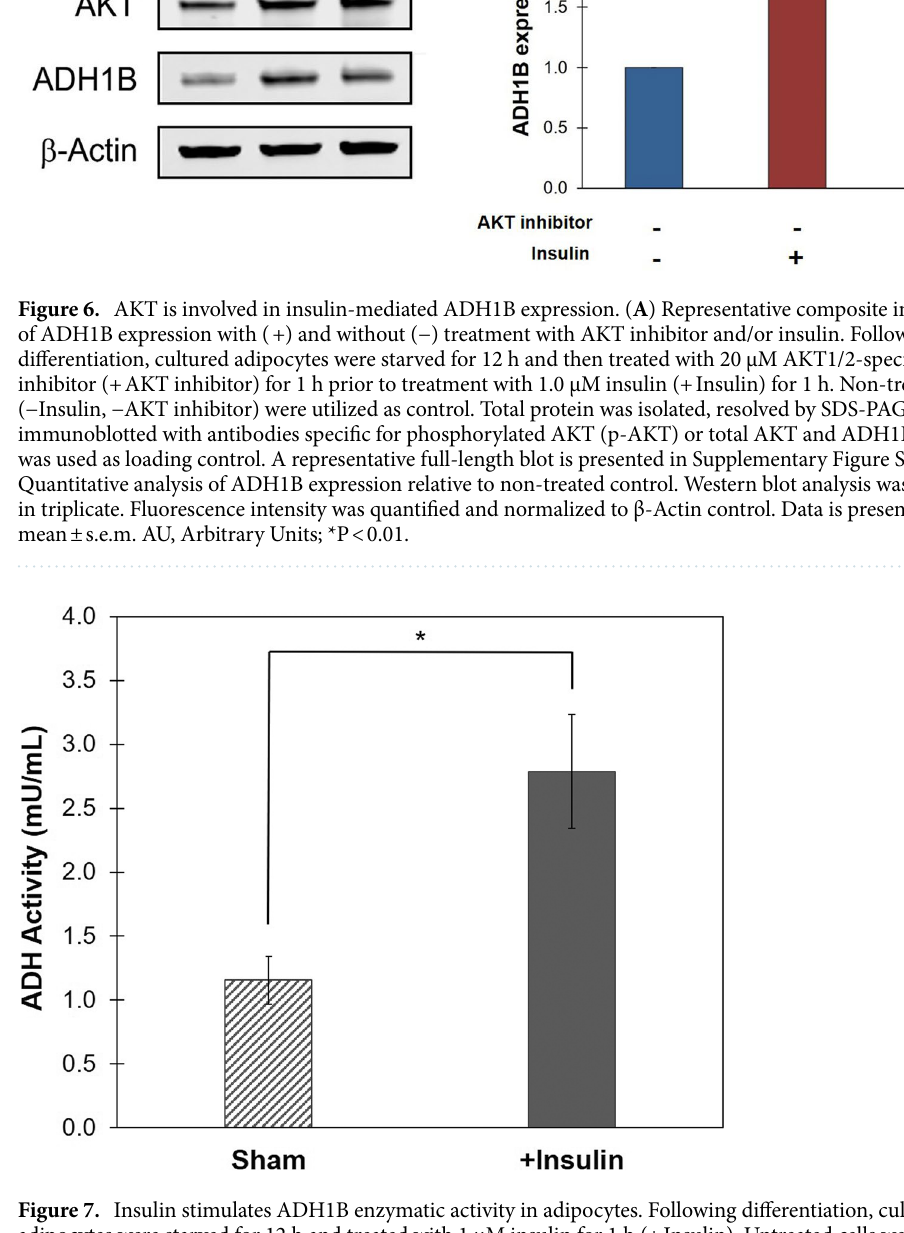
Pre-adipocytes undergoing differentiation were transfected with non-targeting, i.e. “Scramble”, control siRNA or ADH1B-specific siRNA at Day 9–10 of differentiation. After Day 14, insulin stimulated glucose uptake in mature adipocytes was measured by a cell-based colorimetric assay in which 2-deoxyglucose (2-DG) was taken up and metabolized to 2-DG-6-phosphate. This product was oxidized to produce a proportional amount of NADPH which was quantified. The results showed that deficiency in ADH1B protein expression significantly (P = 0.04)